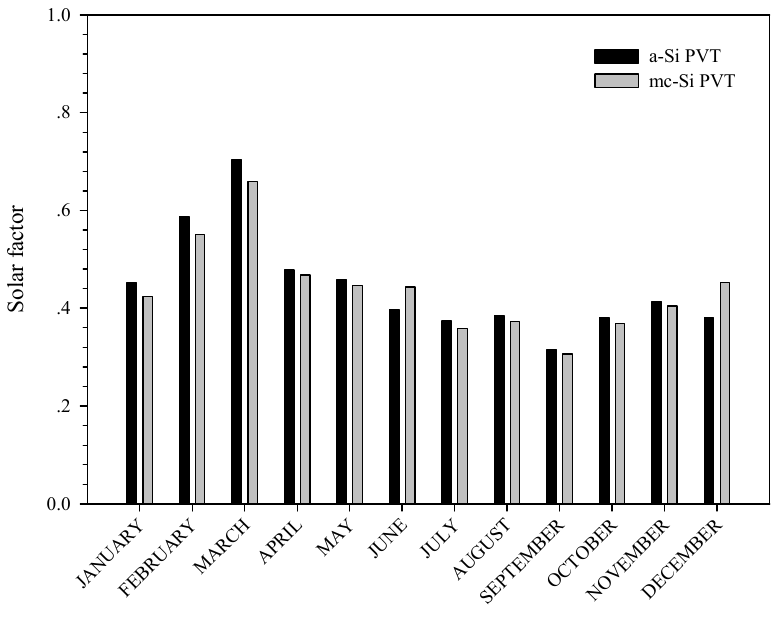
Figure 16. Solar factor of both types PVT collectors (per one square